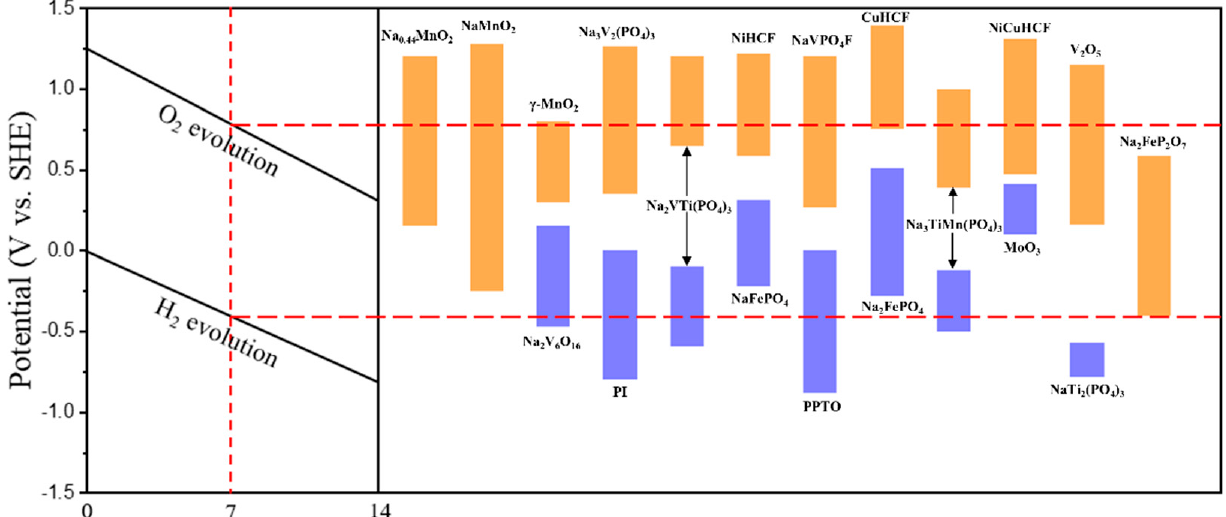
Figure 4. A redox potential and pH − dependent electrochemical stability window for aqueous electrolyte in ASIBs.